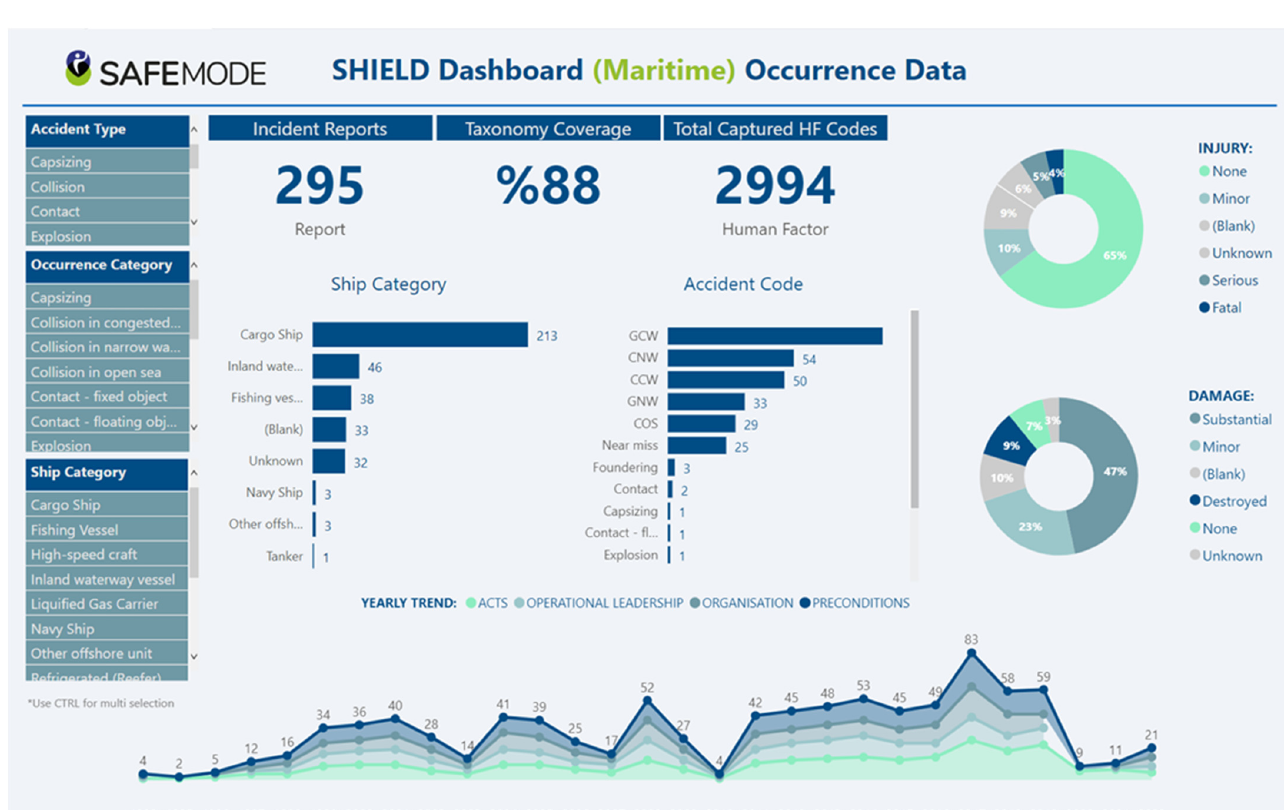
Figure 3. Impression of SHIELD dashboard for maritime occurrences [24].